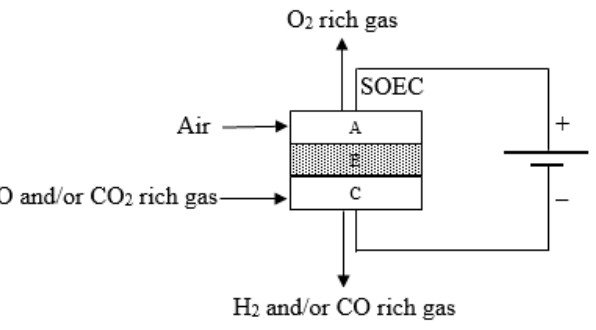
Figure 1. Simplified lay-out of IT-SOEC system fed by H 2 and/or CO 2 rich gas and air.